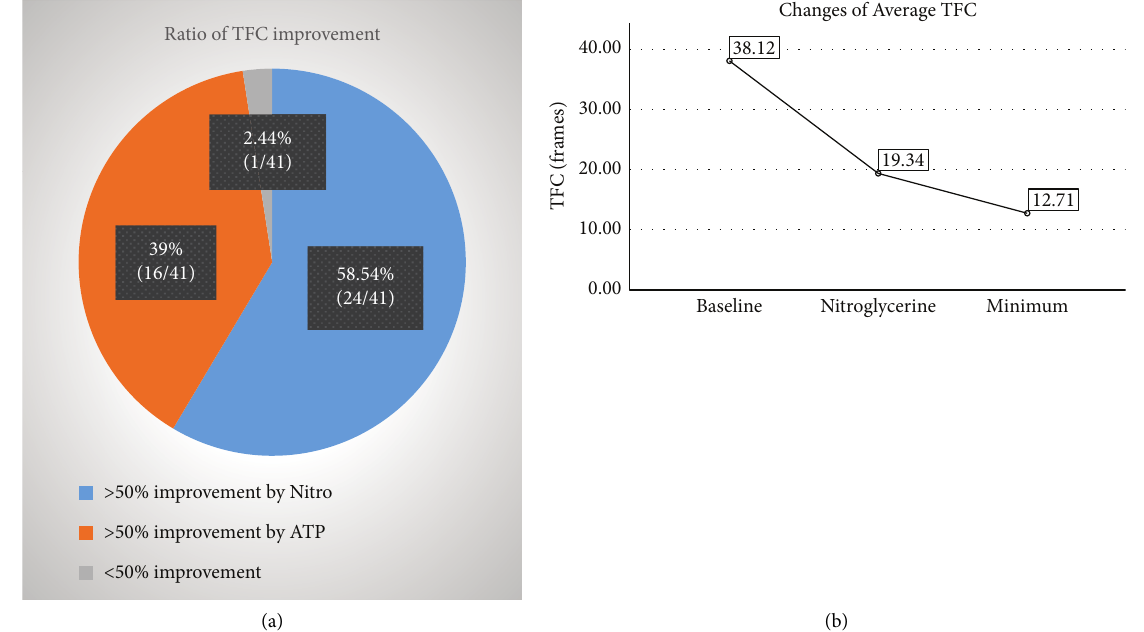
Figure 1: (a) The proportion of TFC improved by nitroglycerin or ATP; (b) the extent to which TFC can be reduced after intracoronary nitroglycerin injection and after sequential ATP injection.